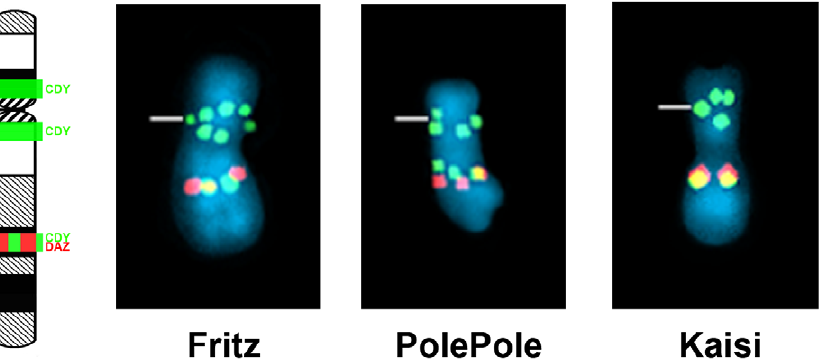
Figure 1. FISH mapping of ampliconic genes DAZ and CDY on Y chromosomes of gorilla. FISH patterns for DAZ (red) and CDY (green) illustrated for the western lowland gorillas ‘‘Fritz’’ and ‘‘PolePole’’, and eastern lowland gorilla ‘‘Kaisi’’. The band locations of each gene are shown on the ideograms to the left. Yellow signals result from overlapping of red and green signals. Centromeres are marked by horizontal lines. Band nomenclature follows the ISCN [71].